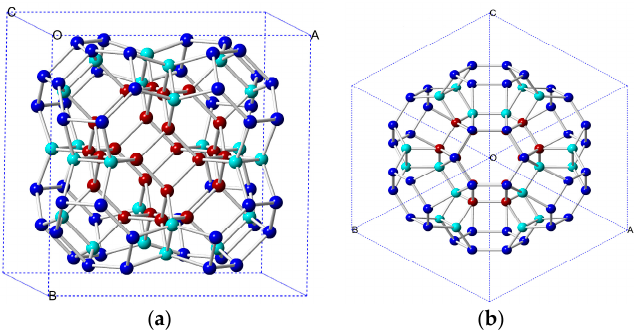
Figure 1. Unit cell crystal structures of Si 96 ( a ) and along the [111] direction ( b ). There are eight bond lengths in Si 96 , namely, 2.3397, 2.3398, 2.3514, 2.3557, 2.3858, 2.3873, 2.4419